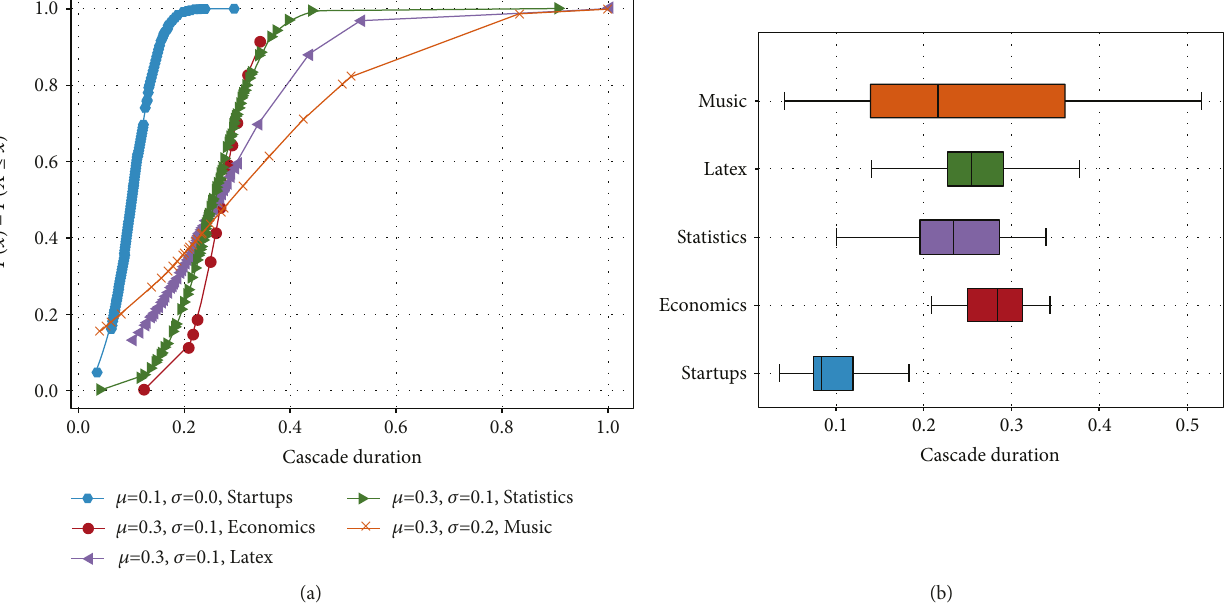
Figure 5: The fi gure shows the cascade duration as CDF (a) and as box plots (b). Cascade duration is normalized based on the number of networks available for each subwebsite.